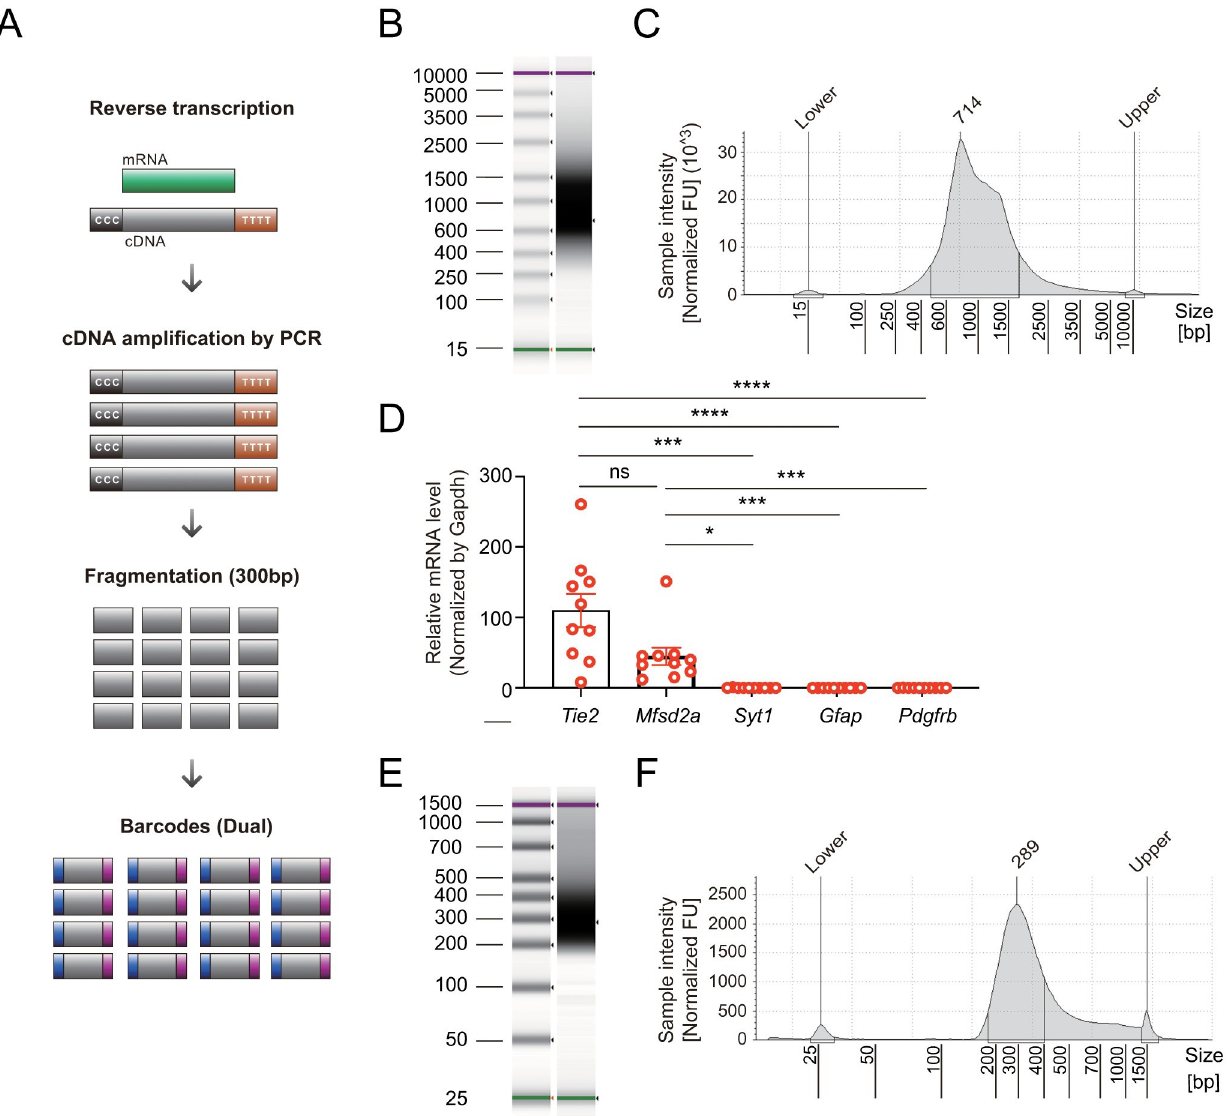
Fig 3. Generation of cDNA libraries for NGS from the low mRNA yield derived from BECs. (A) The process used to generate a cDNA library for RNA- seq from the small amount of pooled mRNA originating from BECs in the cortex of Tie2-Cre; Ai9; Rpl22 HA/HA mice. TapeStation gel image (B) and electropherogram (C) showing PCR amplification of the cDNA library from the cortex of Tie2-Cre; Ai9; Rpl22 HA/HA mice. (D) The specificity of the cDNA library from the cortex of Tie2-Cre; Ai9; Rpl22 HA/HA mice was verified by using RT–qPCR. Mean ± SEM; � P < 0.05, ��� P < 0.001, ���� P < 0.0001 by the Kruskal–Wallis test, n = 10. After fragmentation into 300 bp pieces and labeling with dual barcode oligos, the quality of the cDNA was validated by using TapeStation gel images (E) and electropherograms (F) .